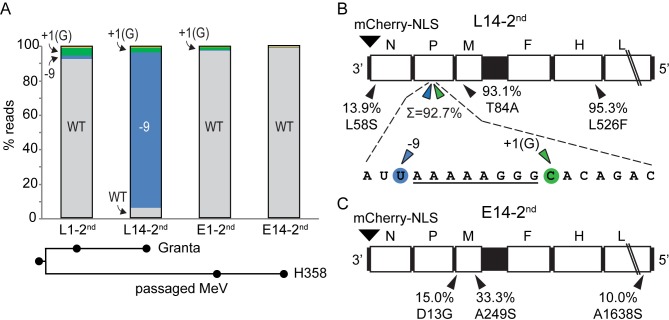
Editing site-proximal variants are consistently selected in lymphocytic cells.(A) Variants are color coded as in Fig 2. The passages analyzed are indicated on the horizontal axis. A schematic of the passage history is indicated below. (B) Genome-wide variants selected by adaptation to lymphocytic cells (L14-2nd). Coding regions are shown in white boxes and non-coding regions in black with the mCherry position indicated above the genome. Variants above 10% as compared to the reference genome are indicated below the genome with their percentage and predicted amino acid changes (arrowheads). (C) Genome-wide variants selected by adaptation to epithelial (E14-2nd) cells. Conventions as in panel B.